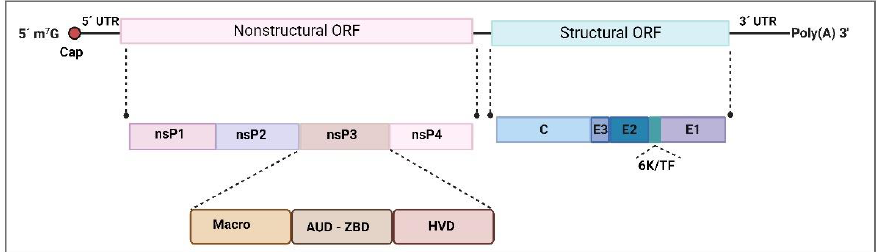
Figure 1. Togaviridae family. Genome structure of Alphavirus and nsP3 non-structural protein domains (the macro domain, the alphavirus unique domain (AUD) and the hypervariable region (HVD). The genome organization can be summarized as 5′ m 7 G Nonstructural ORF-(junction)-Struc- tural ORF-An 3′ , in which two open reading frames (ORFs) are present. The non-structural ORF (NS-ORF) encodes the four non-structural proteins (nsP1-nsP4) which are required for replication. The structural ORF, produced by a subgenomic mRNA, encodes the structural proteins in the viral particle (C, E3, E2, 6K/TF, E1). The genomic RNA with noncoding regions is represented as solid black lines and ORFs as open boxes. Based on Götte et al. (2018) [24] and created with BioRender.com (Accessed on 14 September 2022).